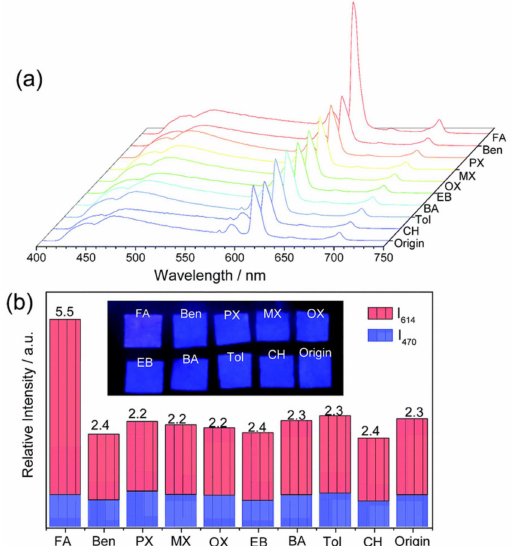
Figure 8. The PL spectra ( a ) and intensities (I614 and I470) ( b ) of Eu 3 + @ZUM test paper after exposure to di ff erent gases in cars ( λ ex = 365 nm). The photo insets of ( b ) are the corresponding pictures under the 365 nm UV irradiation and the given numbers are the I 614 / I 470 values. Reprinted with permission from [38]. Copyright 2017 The Royal Society of